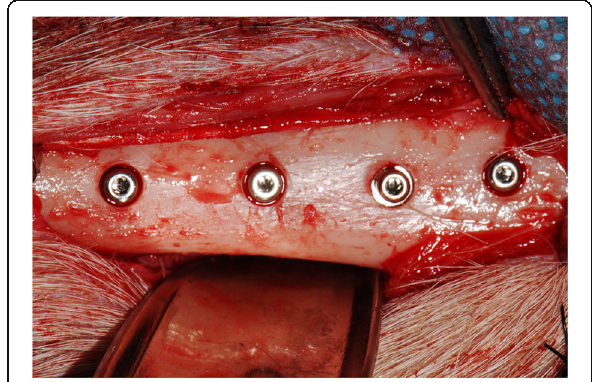
Fig. 1 Two pairs of implants (10 mm × 4 mm, L × Ø) from each of the experimental groups were placed in each tibia with an alternating fashion in terms of medio-distal positioning regarding the group, but with the first group chosen at random. Implants were placed with